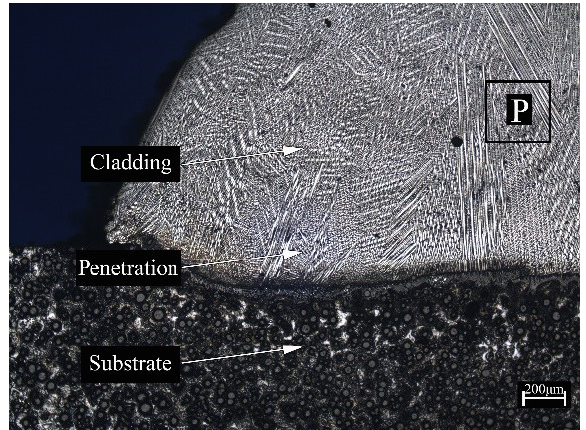
Figure 2. Overview of the cladding.